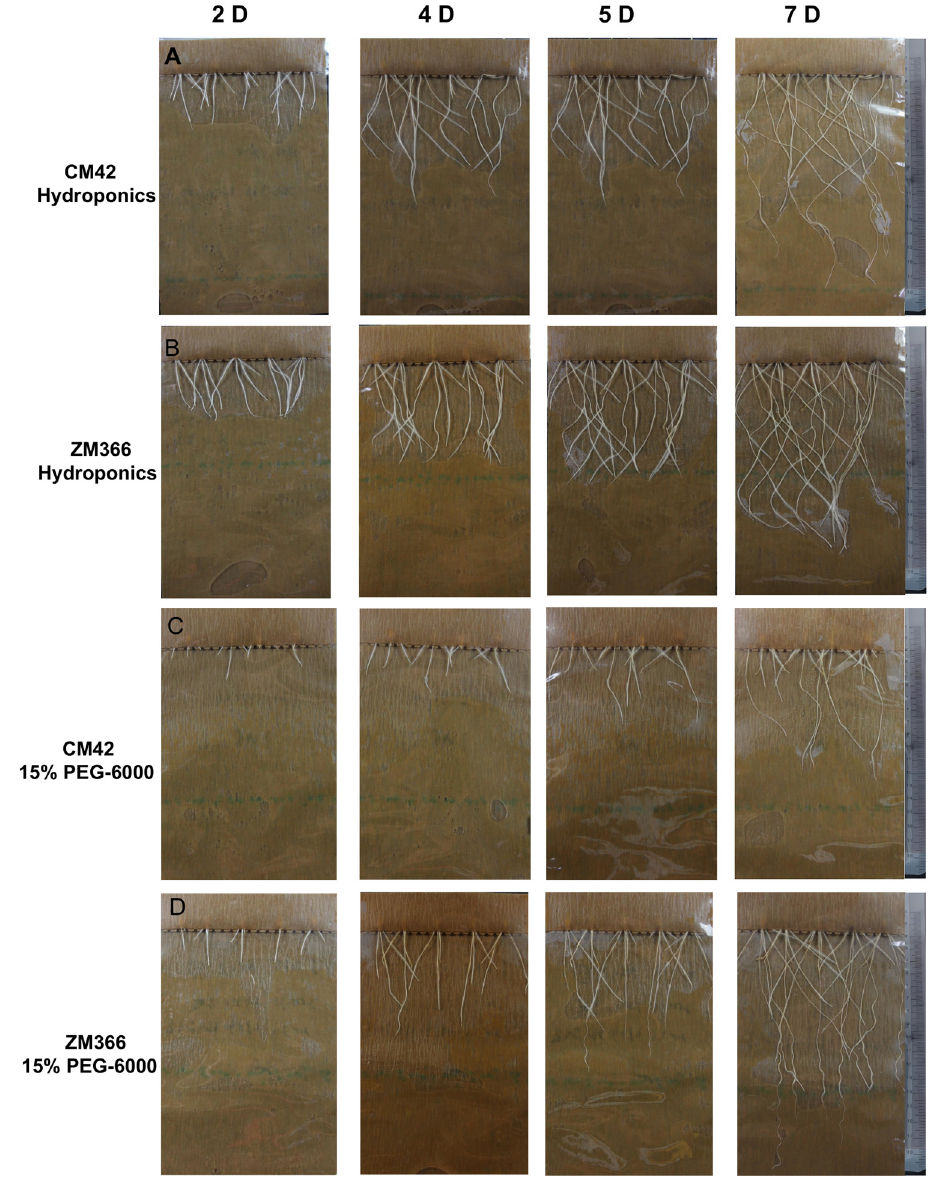
Figure 1. Root growth of CM42 and ZM366. ( A ) CM42 root growth under hydroponic conditions. ( B ) ZM366 root growth under hydroponic conditions. ( C ) CM42 root growth under the 15% PEG-6000 treatment. ( D ) ZM366 root growth under the 15% PEG-6000 treatment. Root growth was measured on days 2, 4, 5, and 7.